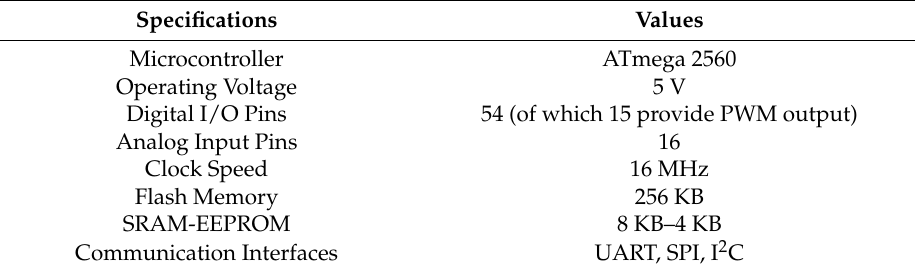
Figure 18. Buck converter and sensors used. 4. Results and Discussion 4.1. Simulation Results Figure 19 shows the output power of the PV module for the inverse neural controller and the P&O algorithm, using a constant temperature of 50 °C and a change in irradiation of 100 to 1000 W/m 2 . It can be observed that the neural controller is more efficient when compared to the P&O, since it eliminates the oscillations around the operating point and presents a better time response. The neuronal controller stabilizes in a time of 0.032 s, while the P&O decreases oscillations in a time of 0.034 s; however, it does not eliminate them completely.